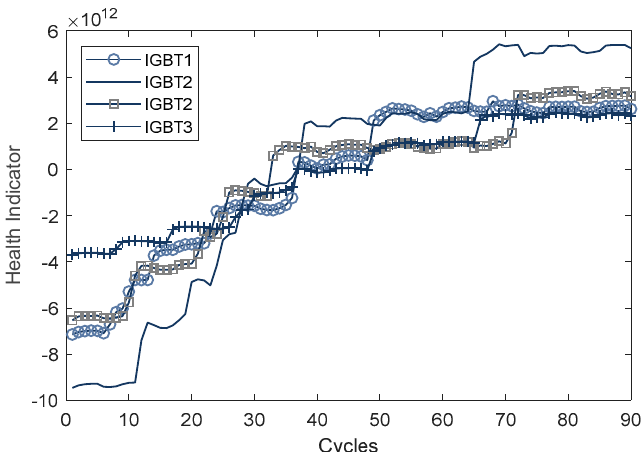
Figure 9. The evolution of the first principal component analysis (PCA) component for four IGBTs components.